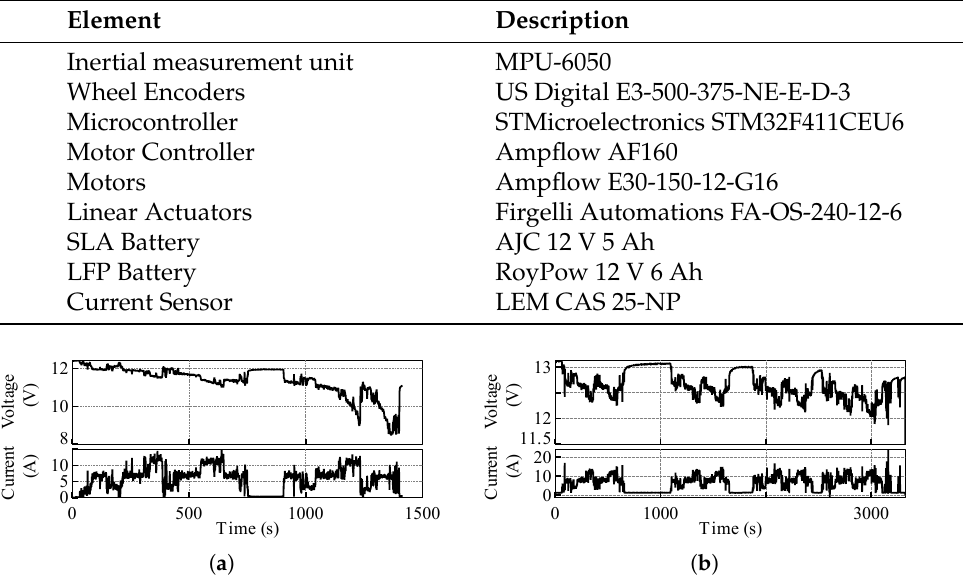
Figure 10. Measured current and voltage during tests with the robotic platform. ( a ) SLA battery pack. ( b ) LFP battery